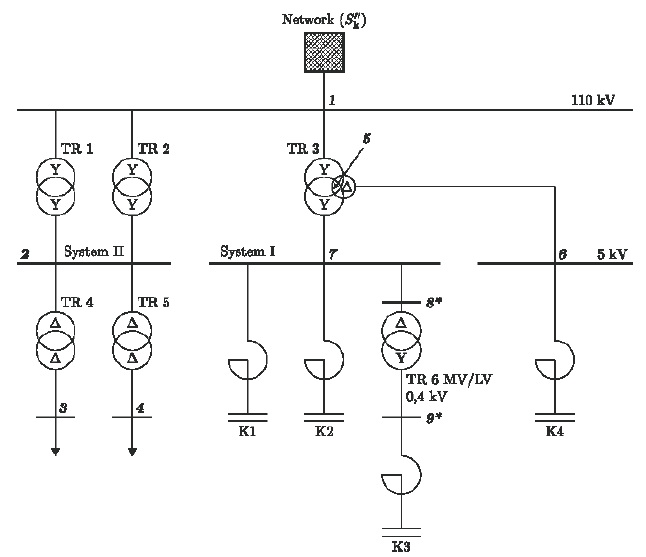
Figure 4. Industrial network